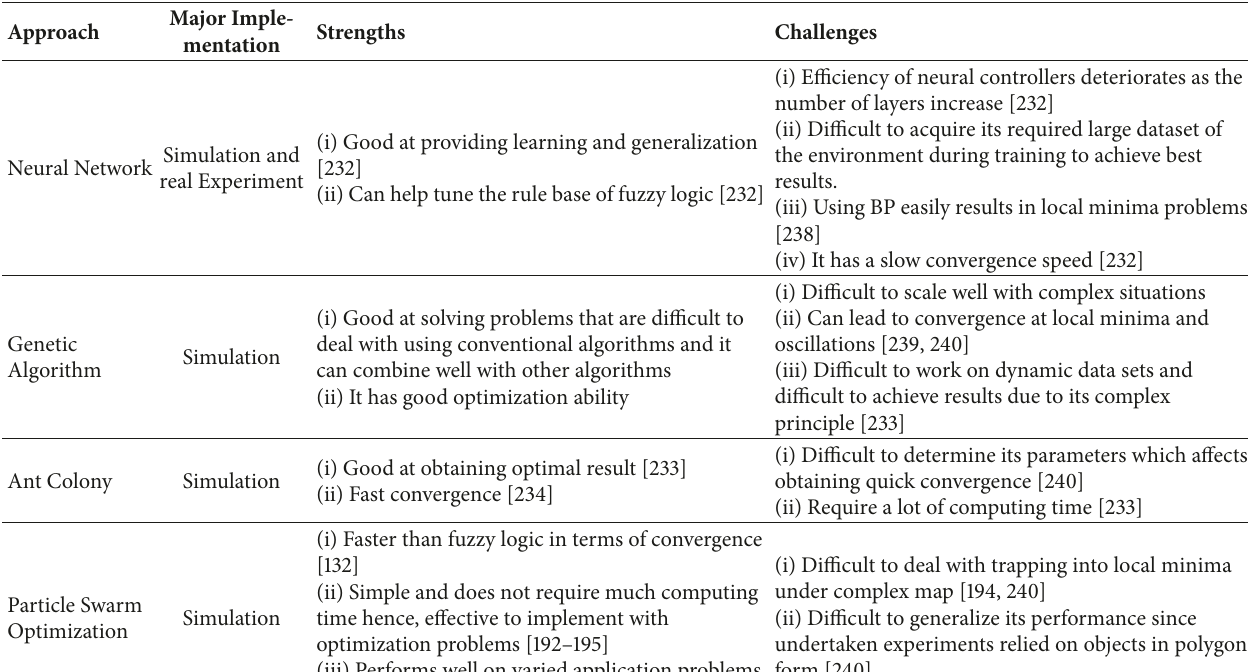
Table 1: Summary of Strengths and Challenges of Nature-inspired computation based mobile robot path planning and obstacle avoidance